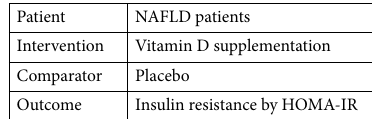
Table 3. PICO framework of the